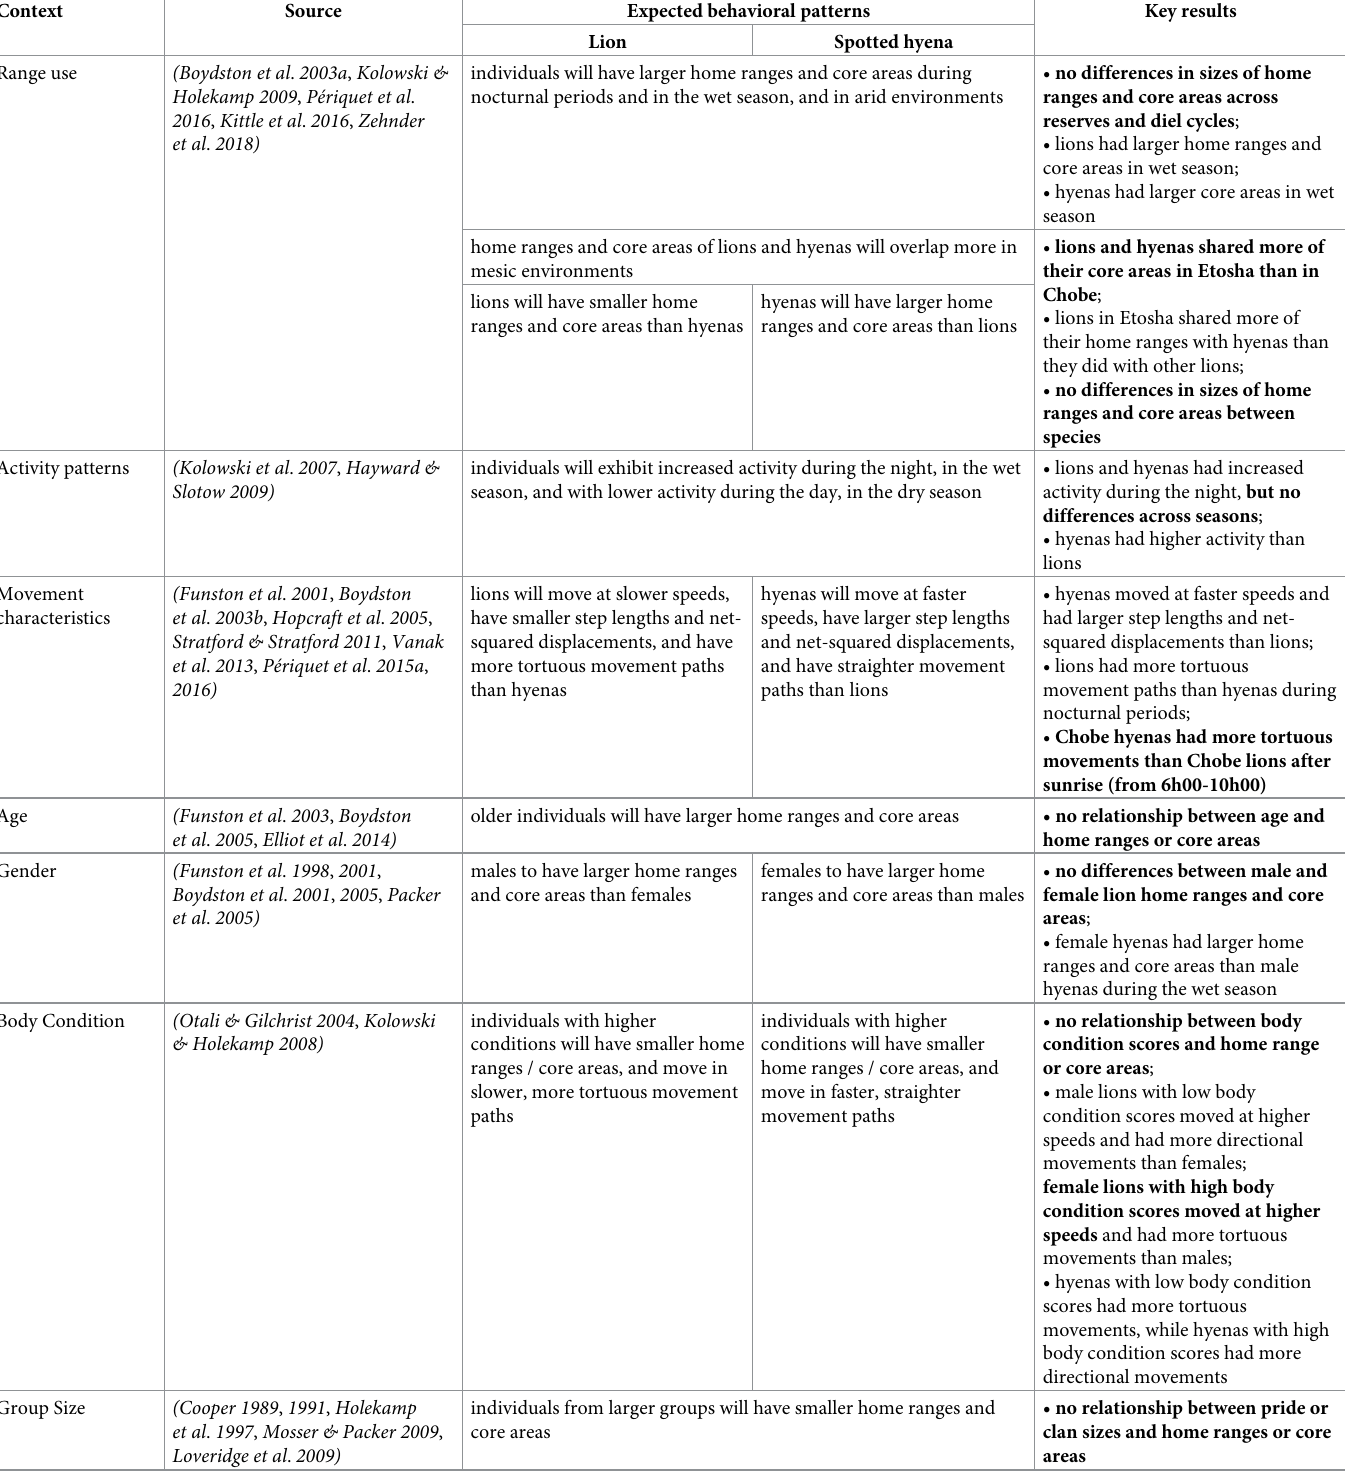
Table 1. Expected behavioral patterns for lions and spotted hyenas, based on literature, for analyses undertaken in this